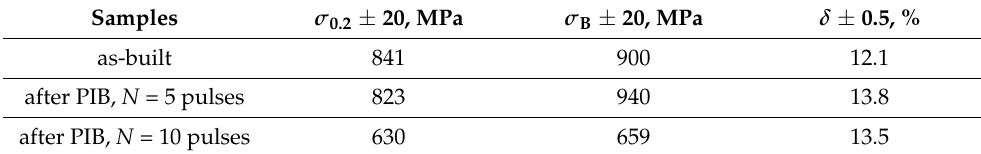
Table 2. Mechanical properties of the EBM Ti-6Al-4V alloy in different